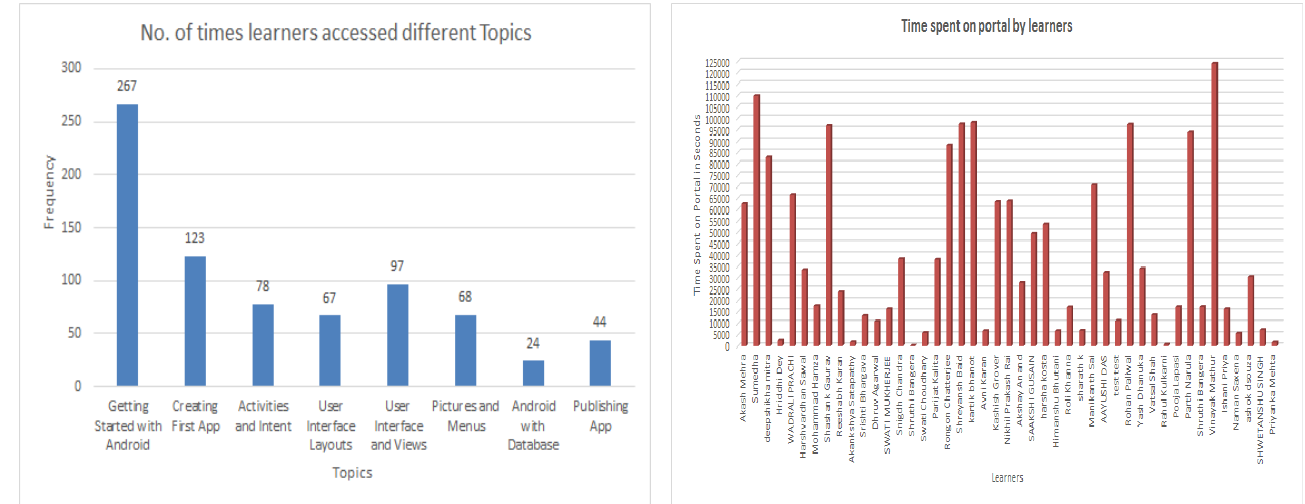
Figure 6. Analysis of Number of Times Learners